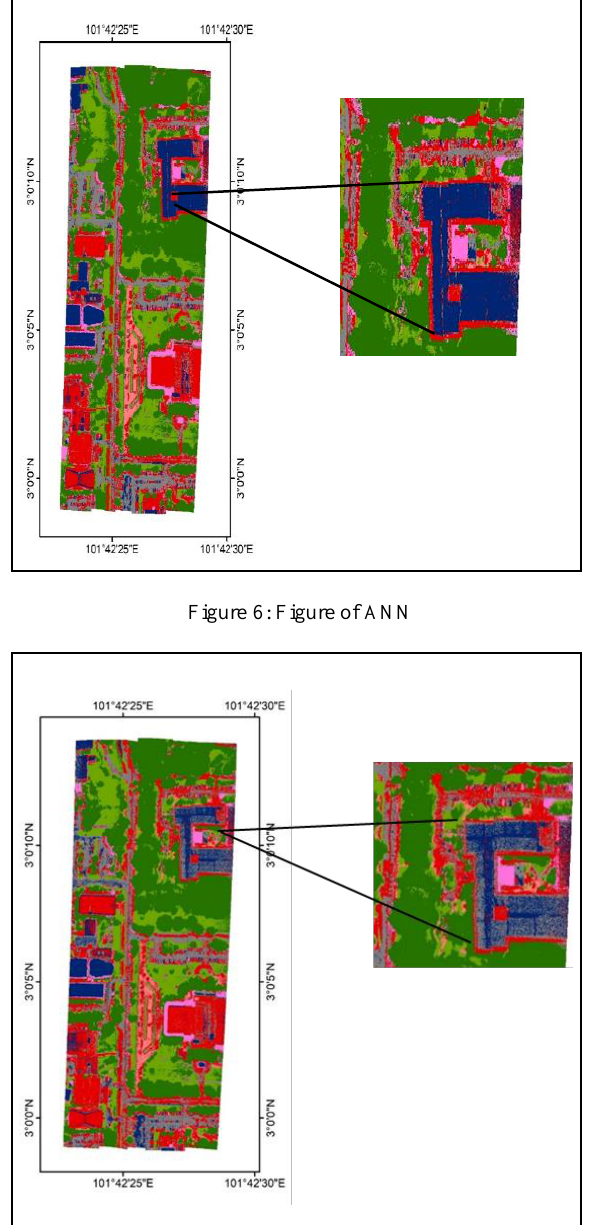
Figure 7: Figure of SVM